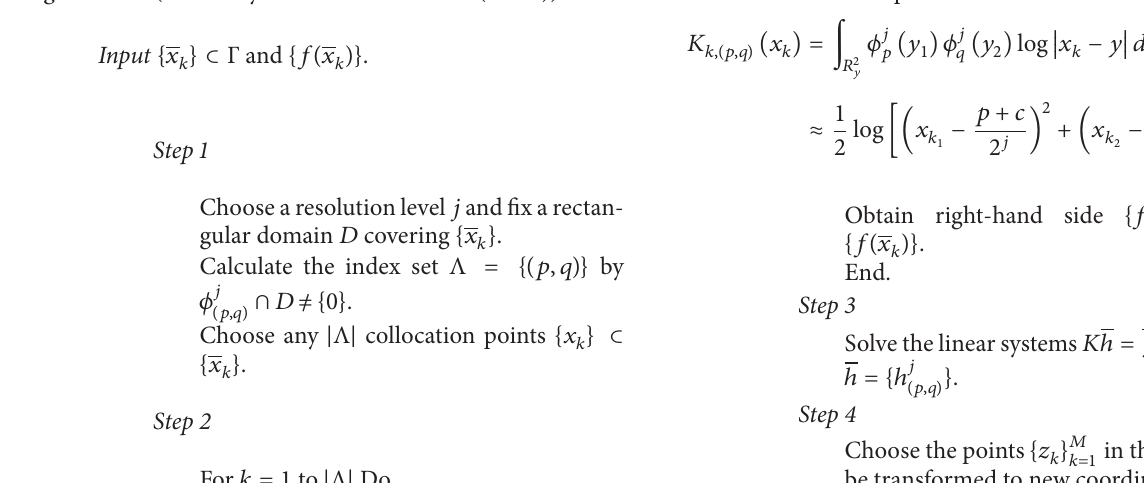
Algorithm 10 (boundary measure and wavelet